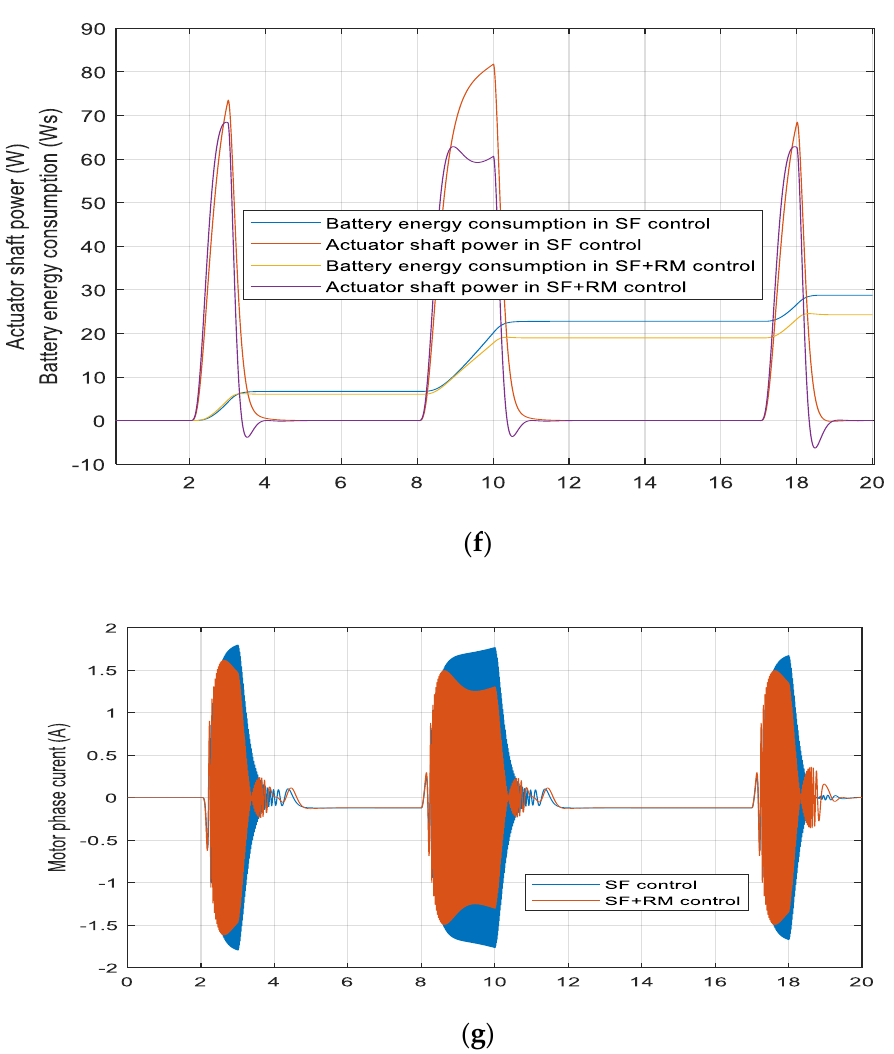
Figure 8. Simulation results at 8 m/s and 5 degrees steering input: ( a ) steering angle; ( b ) tilt angle; ( c ) actuator torque; ( d ) perceived acceleration; ( e ) yaw rate; ( f ) actuator power and battery energy consumption; and ( g ) servo motor phase current.